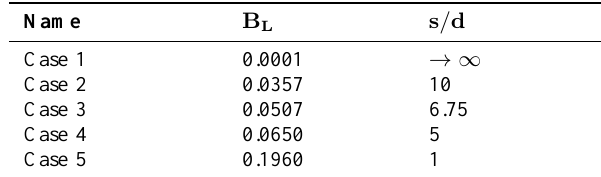
TABLE I R OTOR DESIGN